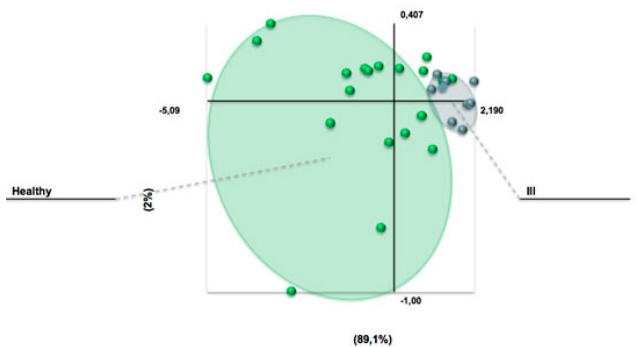
Figure 1. PCA related to the chosen array. Here are shown 18 control samples (green dots) and 10 samples from subjects with CCR (blue dots). The areas represent the two populations.